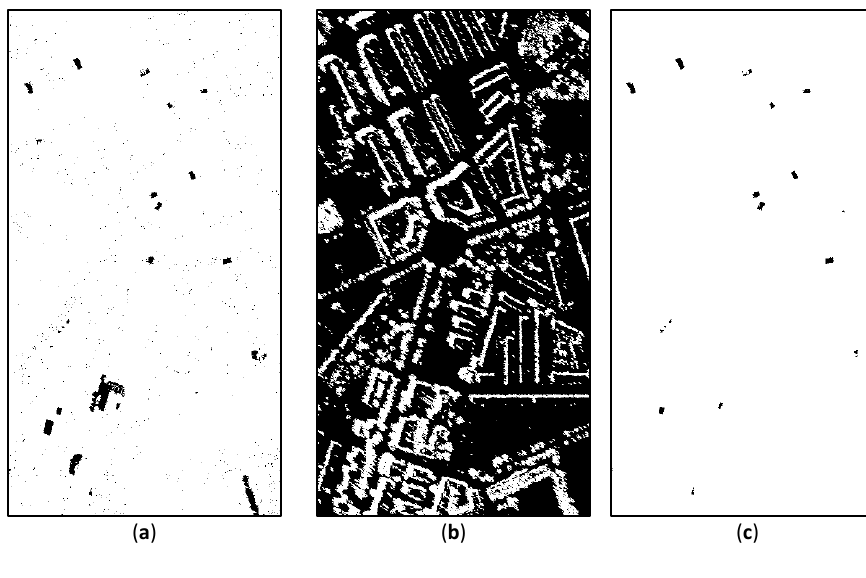
Figure 9. ( a ) Swimming pools detected with false positives in shadowed areas; ( b ) shadowed regions in the studied area (white color represents shadowed areas, black shows no dark regions); and ( c ) swimming pools detected after removing false positives in shadowed